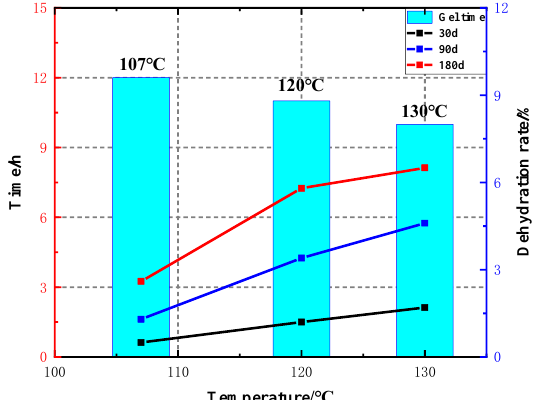
Figure 8. Effect of temperature on the stability of frozen gel. Note that the left y-axis values in Figure 8 is used for histograms, and the right y-axis values are used for the line charts; 30 d/90 d/180 d represent 30 days, 90 days, 180 days of dehydration, respectively.